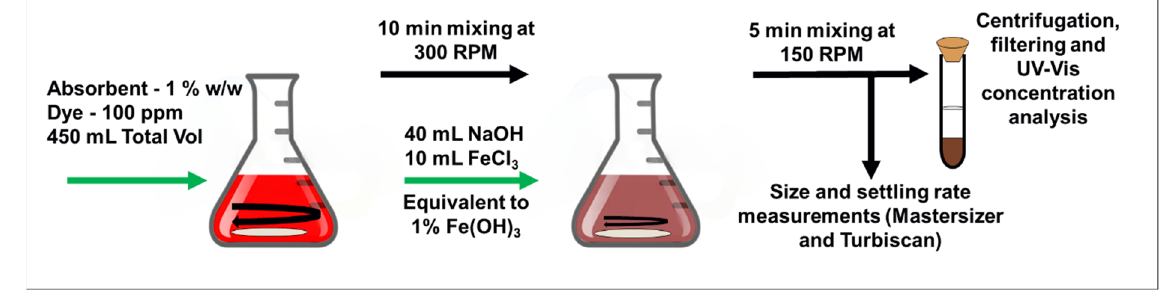
Figure 1. Schematic of the experimental method for combined adsorption and coagulation batch tests.